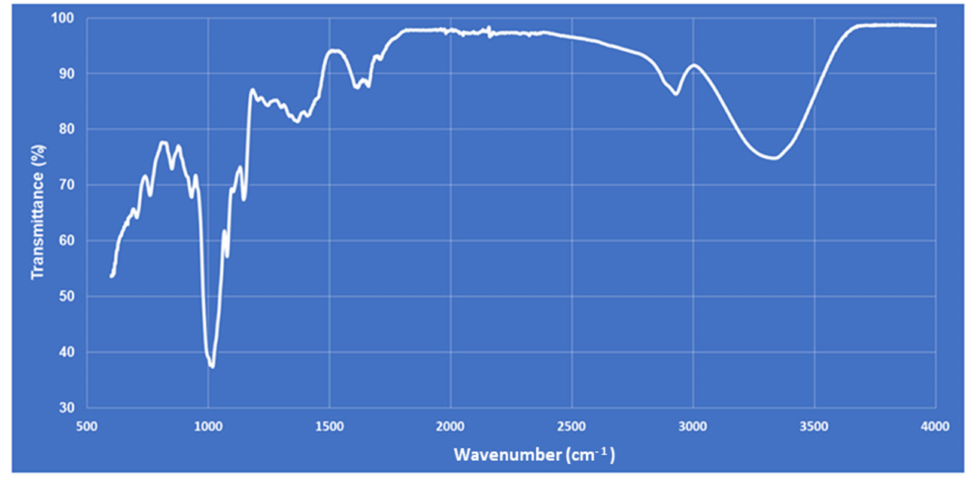
Figure 3. FT-IR spectra of